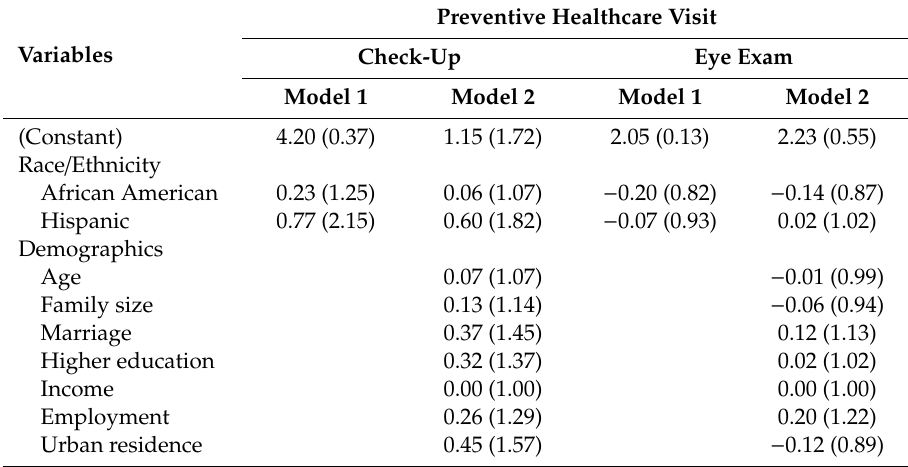
Table 3. Logistic regression coe ffi cients (odds ratio) of predicting preventive healthcare visit.